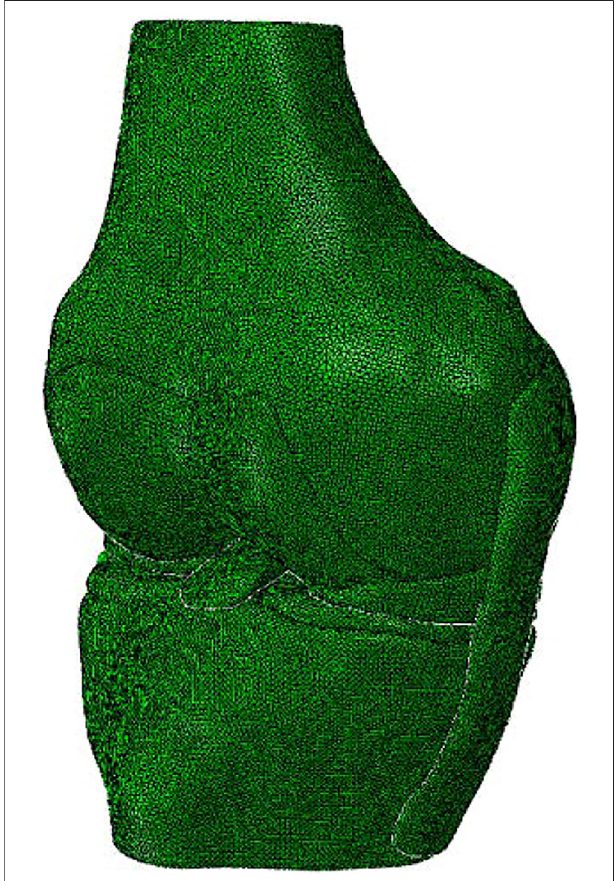
FIGURE 1 | A three dimensional (3D) fi nite element model of the knee joint was reconstructed using Abaqus/CAE 6.14.